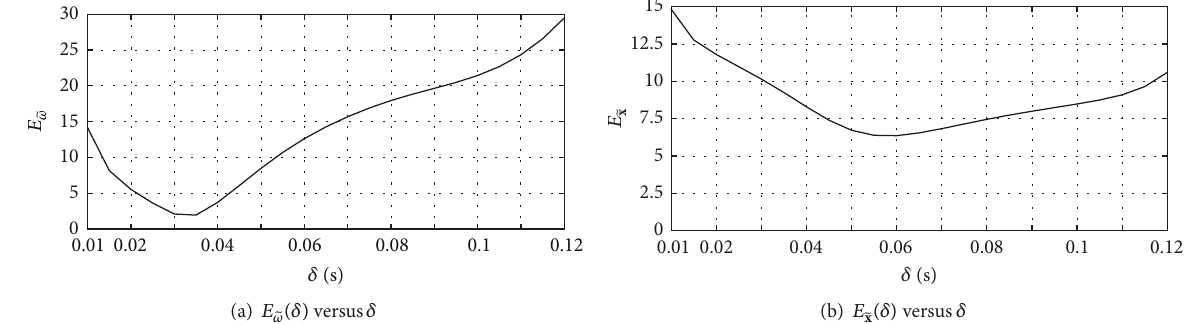
Figure 4: Functions 𝐸 ̃𝜔 (𝛿) and 𝐸 ̃ x (𝛿) computed when all the floors are instrumented.